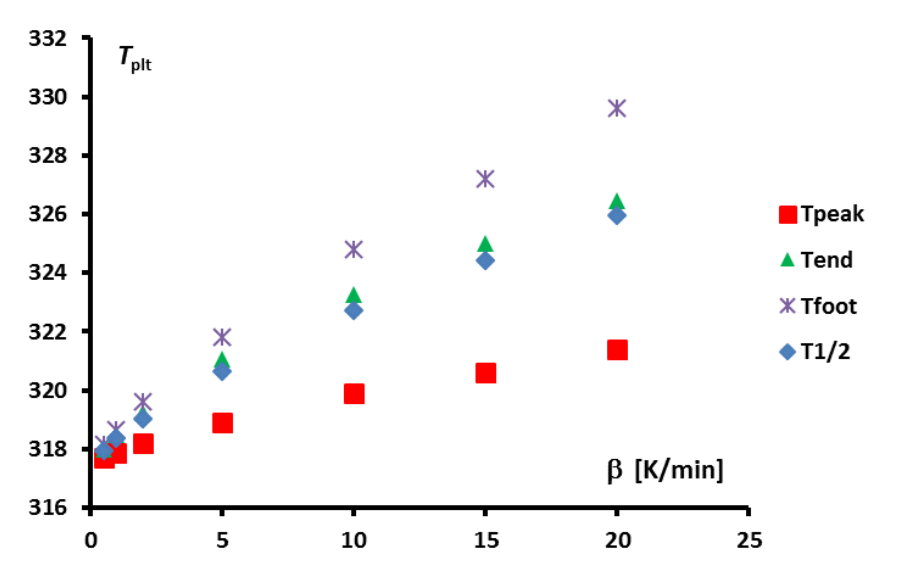
Figure 31. Determination of T liquidus the temperature of the liquidus, for x 0 = 0.8, by the characteristic temperatures of the end of the peak versus β ; from